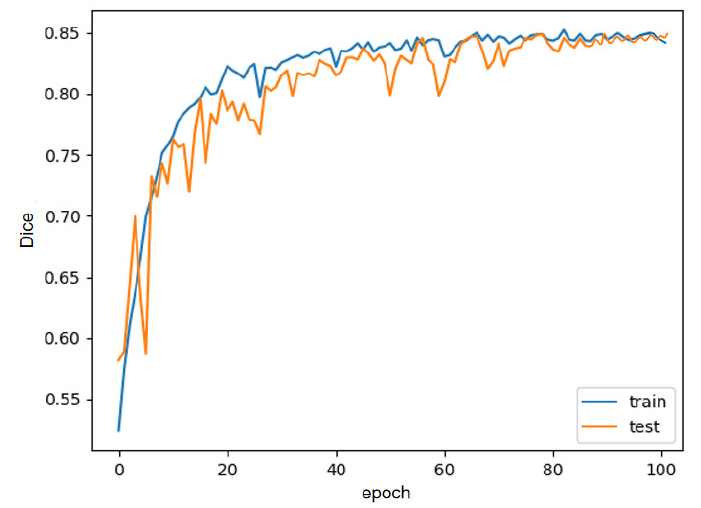
Figure 8. Dice similarity coefficient curve.